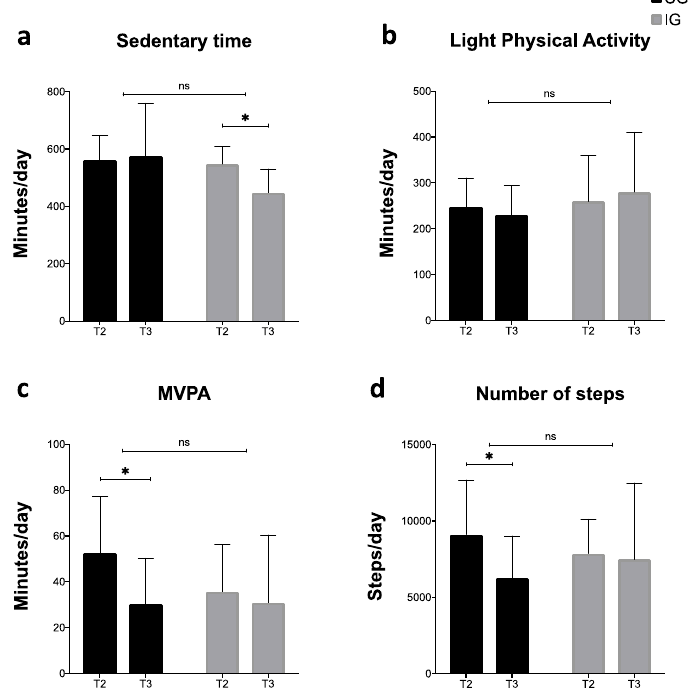
Figure 5. Intra and inter-group physical activity comparisons. MVPA: Moderate to vigorous physical activity; CG: control group; IG: intervention group. NH: national holidays; *Statistical significance ( p < 0.05); NS: no significance.